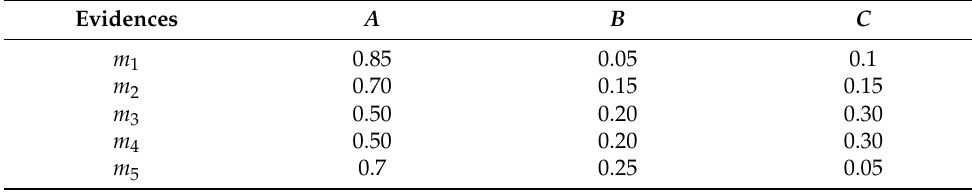
Table 9. Normal evidence body data